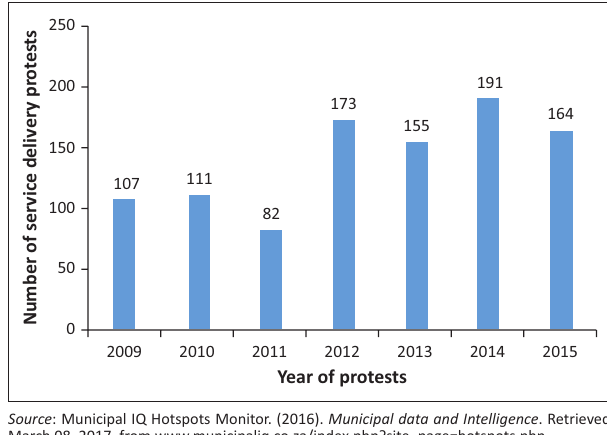
FIGURE 1: Major service delivery protests in South Africa over the period